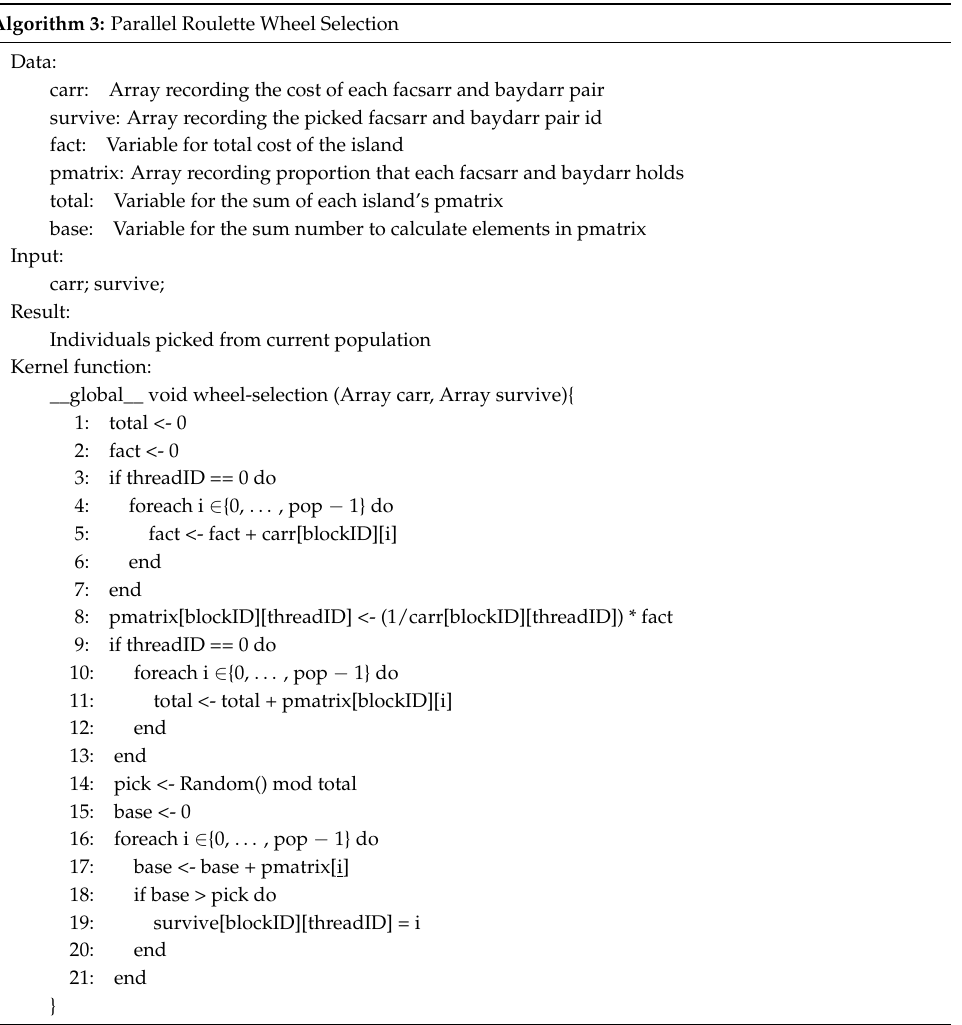
Figure 8. Parallel roulette wheel selection of SEL_RL. Algorithm 3: Parallel Roulette Wheel